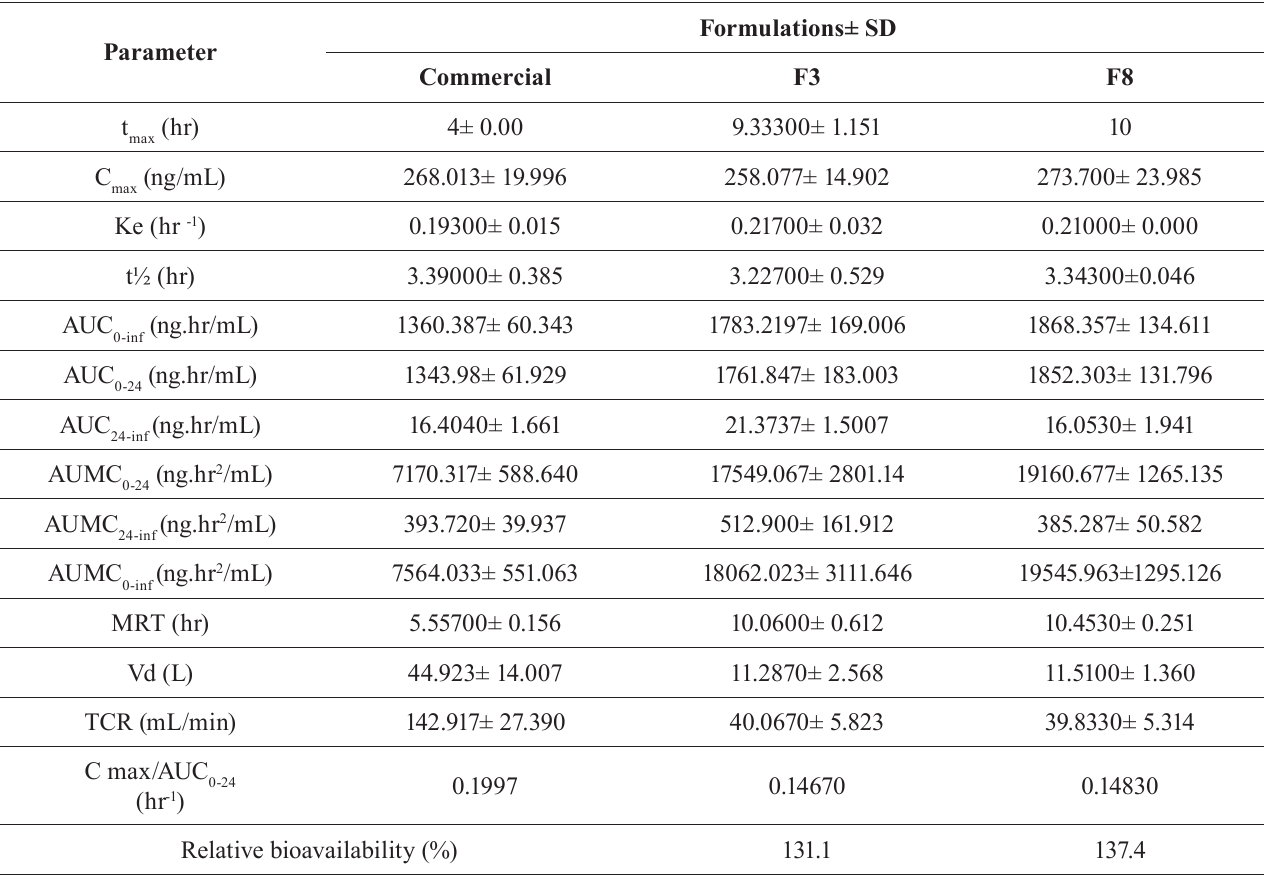
TABLE IV - Mean pharmacokinetic parameters after oral administration of commercial and tested Eplerenone